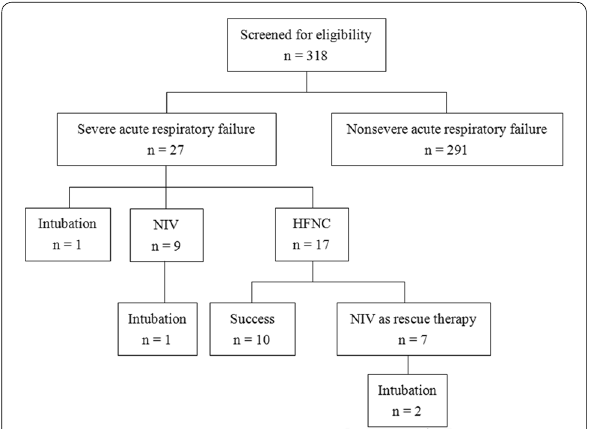
Fig. 1 Flow of patient screening and